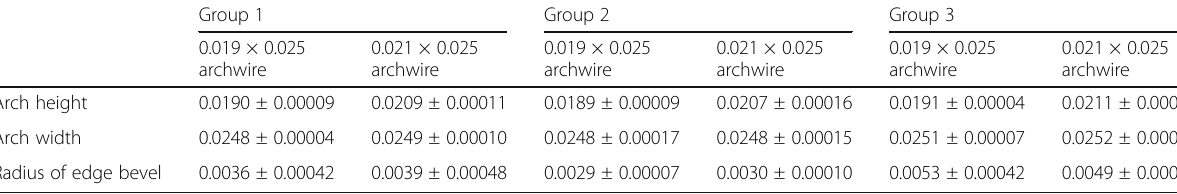
Table 4 Descriptive statistics for archwire ’ s measurements divided by group and